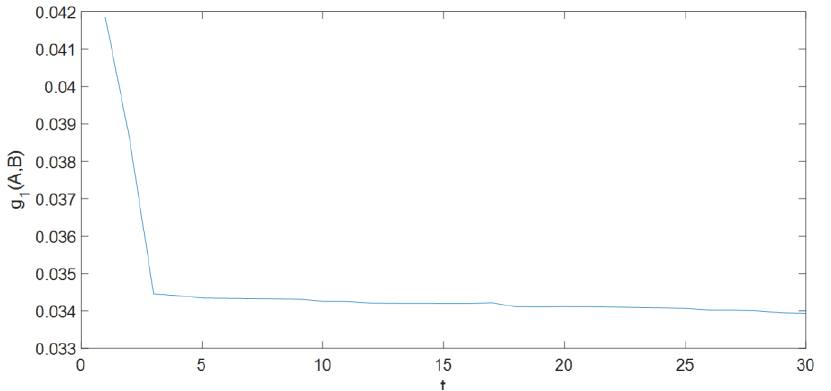
Fig. 2. Convergence of the